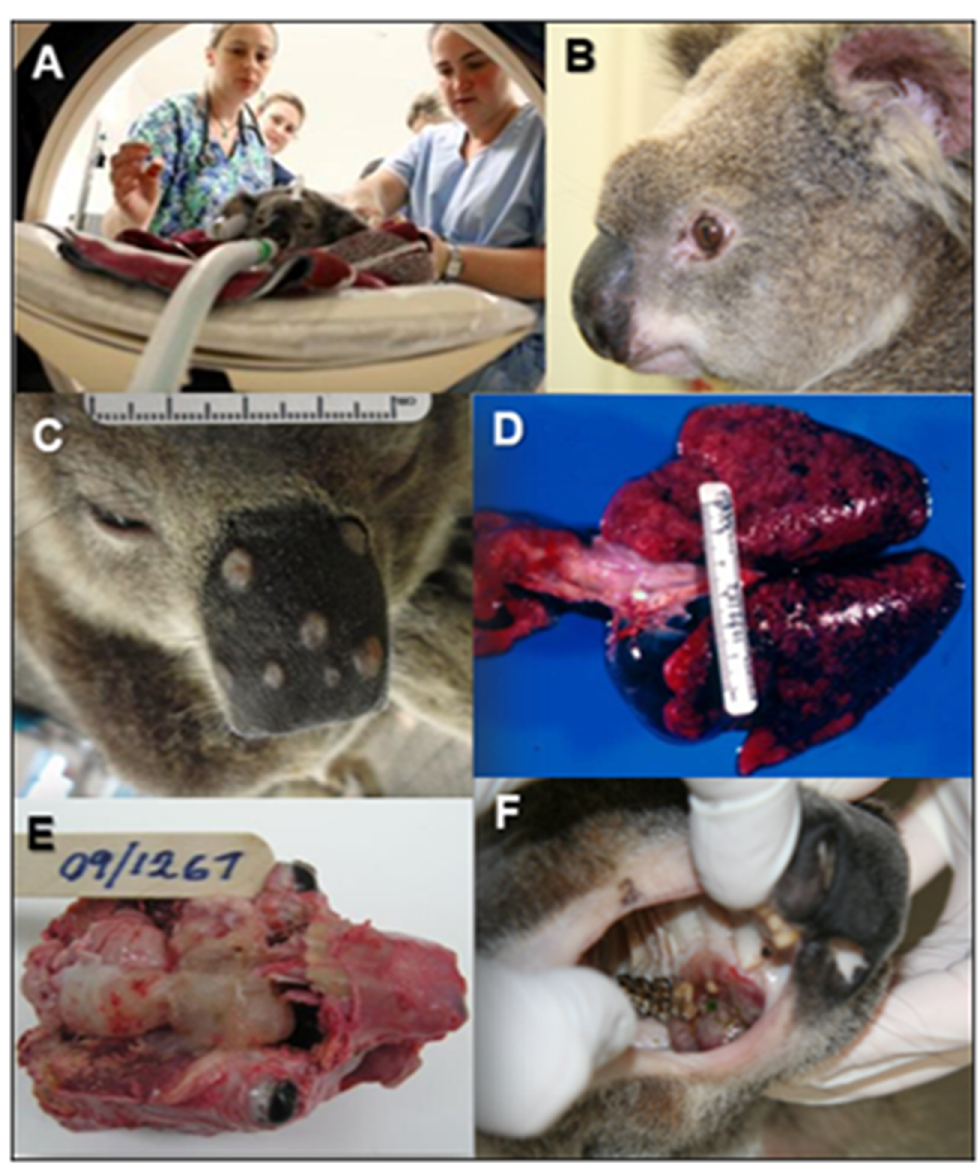
Figure 4. Cryptococcosis in the koala. ( A ) Koala with sinonasal cryptococcosis undergoing a computerized tomography scan. ( B ) Koala with destructive cryptococcal rhinitis due to C. gattii . ( C ) Multifocal skin involvement over the planum nasale of a koala with C. gattii infection. ( D ) Lungs from a koala that died of pneumonia due to C. gattii and Bordetella bronchiseptica . ( E ) Koala with cryptococcal rhinosinusitis with extension to the brain. ( F ) Koala with cryptococcal rhinitis with ventral extension to involve the hard palate.